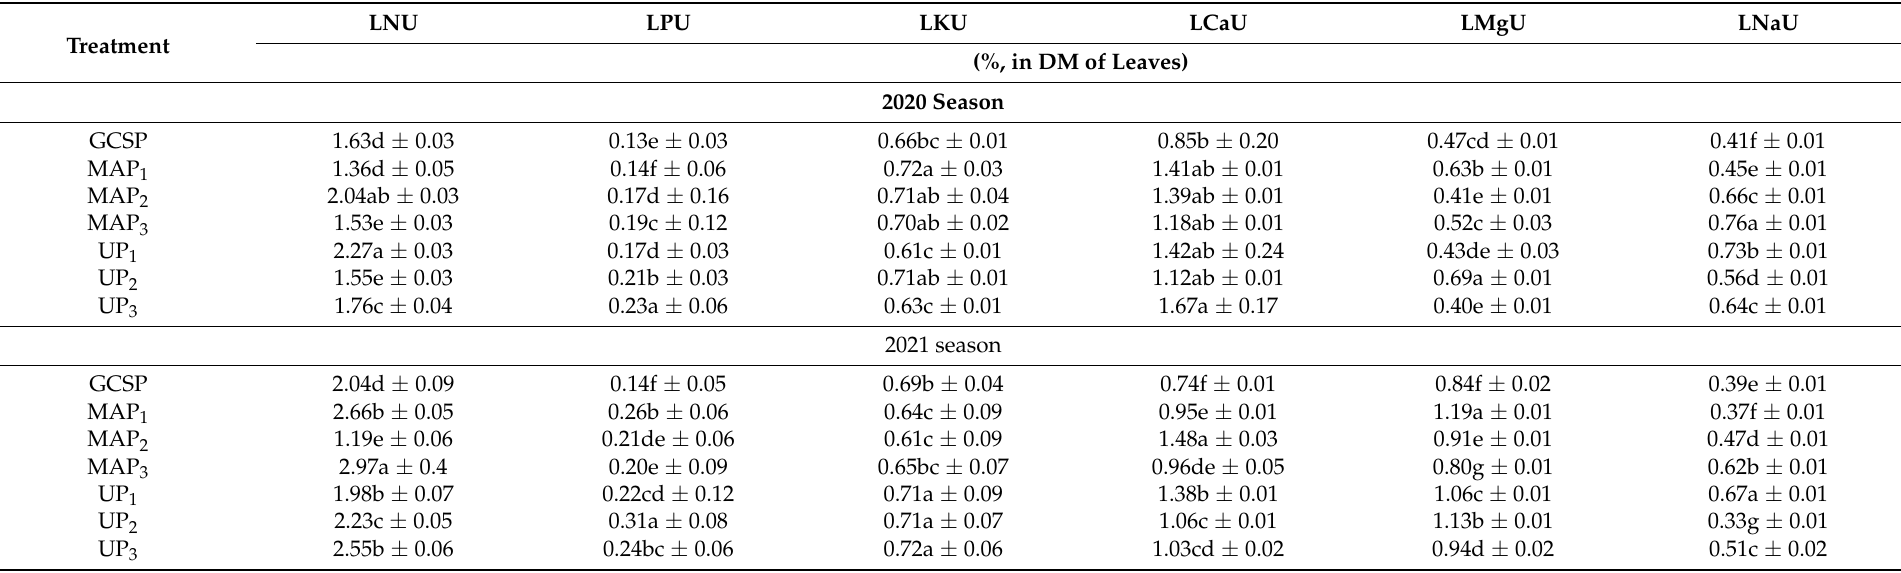
Table 5. Influence of different levels of MAP and UP in a comparison with the recommended GCSP level on leaf macronutrient uptakes of olive ( Olea europaea L. arbequina cv.) trees grown in sandy loam clay soil under multi-abiotic stresses (CaCO 3 = 8.8 vs. 9.2%, ECe = 6.4 vs. 7.2 dS m − 1 ,